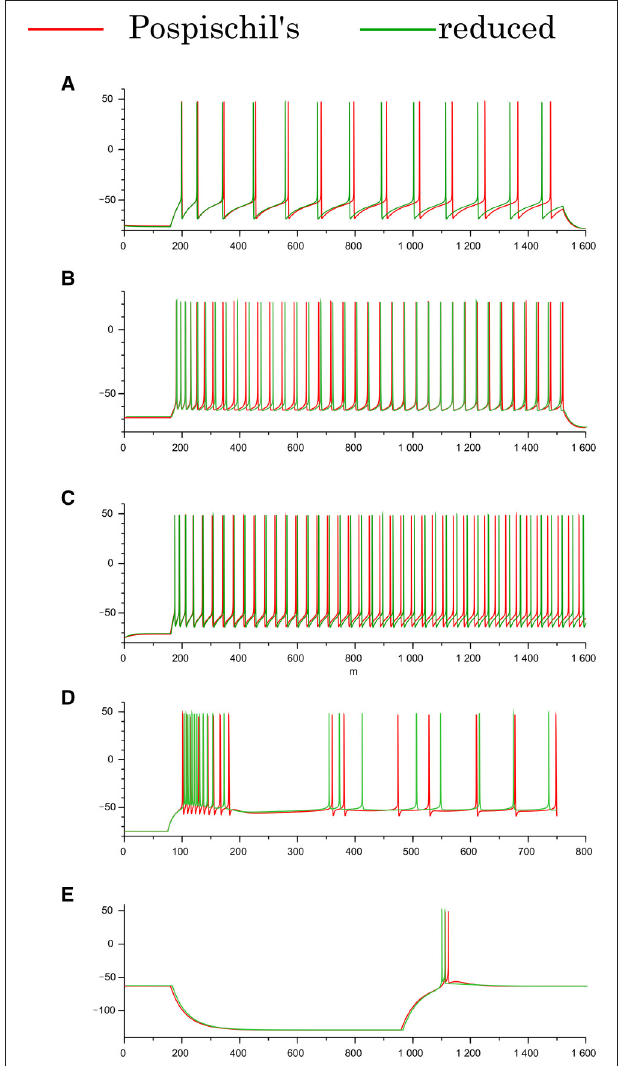
FIGURE 2 | Waveforms of the Pospischils’ and reduced models in the cortical and thalamic neuron classes. (A) The excitatory RS class, (B) the inhibitory RS class, (C) the FS class, (D) the IB class, and (E) the LTS class, respectively. An excitatory step stimulus is applied in (A–D) . An inhibitory pulse stimulus that starts at 180 ms and ends at 980 ms is applied in (E)